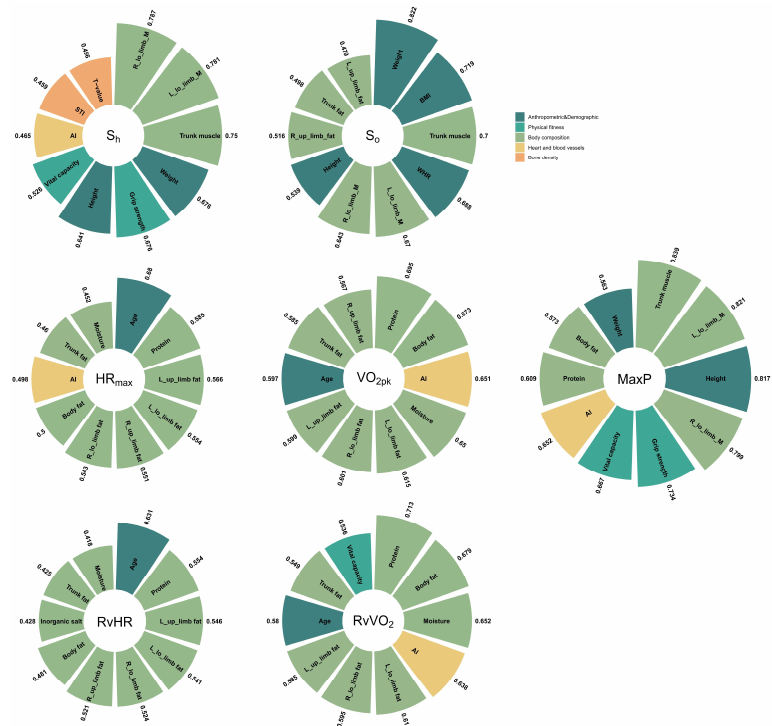
Figure 2. Details of the top ten Non-In data with the relationships to each of the exercise data. The different colors represent the specific categories to which the data belong. The numbers outside the sector represent their correlation values.